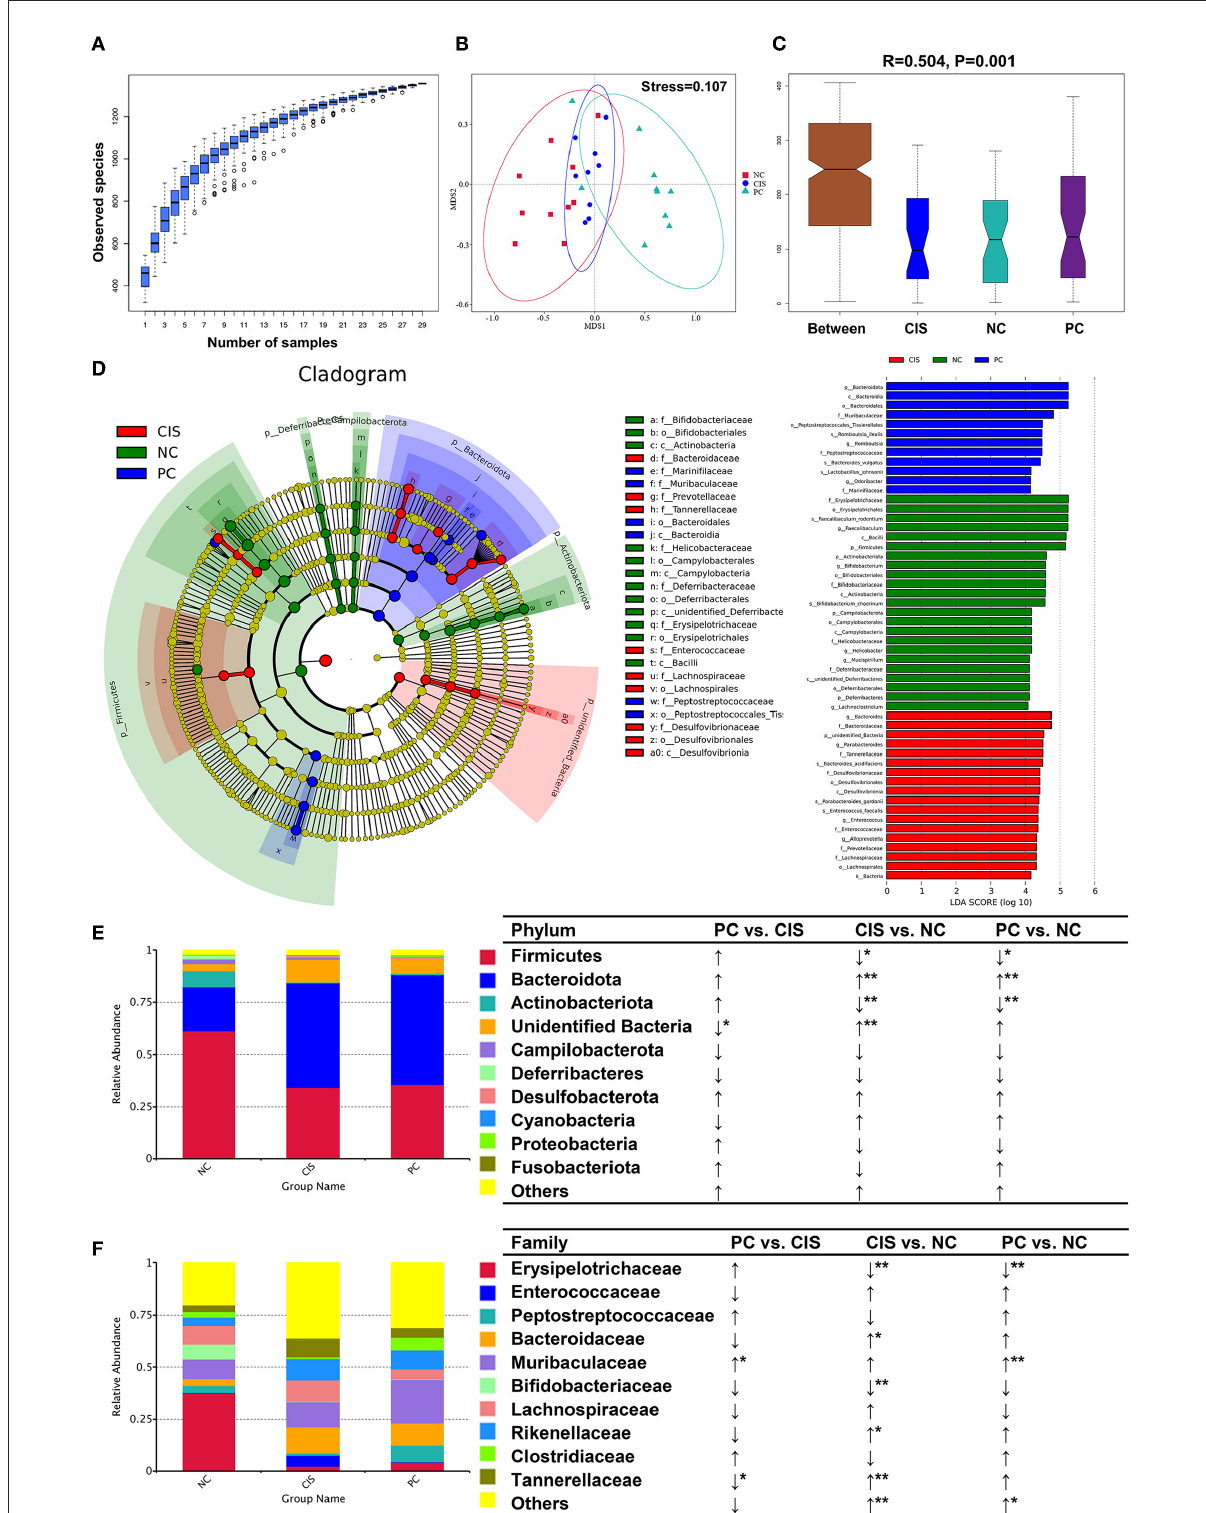
FIGURE3 Gut microbiota analysis. (A) Species accumulation boxplot of all samples; (B) non-metric dimensional scaling (NMDS) plots; (C) analysis of similarities (ANOSIM) showed the significance of separation among the NC, CIS, and PC groups; (D) Linear discriminant analysis Effect Size (LEfSe) analysis (the filter value of LDA score is 4); (E) relative abundance of the top 10 phyla; (F) relative abundance of the top 10 families. n = 10 for the PC and NC groups, n = 9 for the CIS group (one mouse in the CIS group died before collecting feces). NC, normal control; CIS, cisplatin; PC, cisplatin with C-phycocyanin; * p < 0.05, ** p < 0.01; ↑ , upregulation; ↓ ,